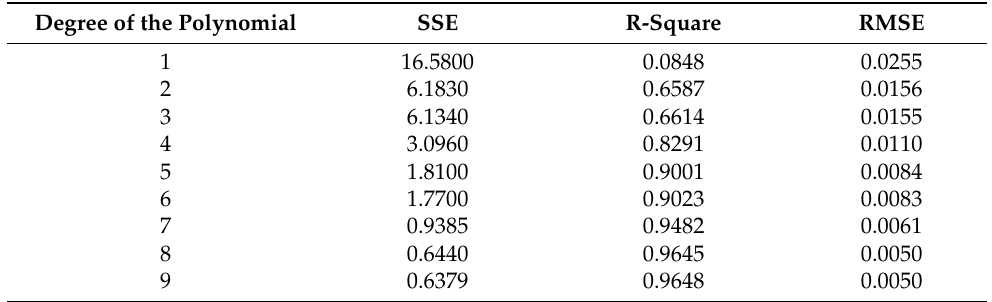
Table 10. Precision analysis of the different curve fitting polynomials used for the NS-LS cross-section. Degree of the Polynomial SSE R-Square